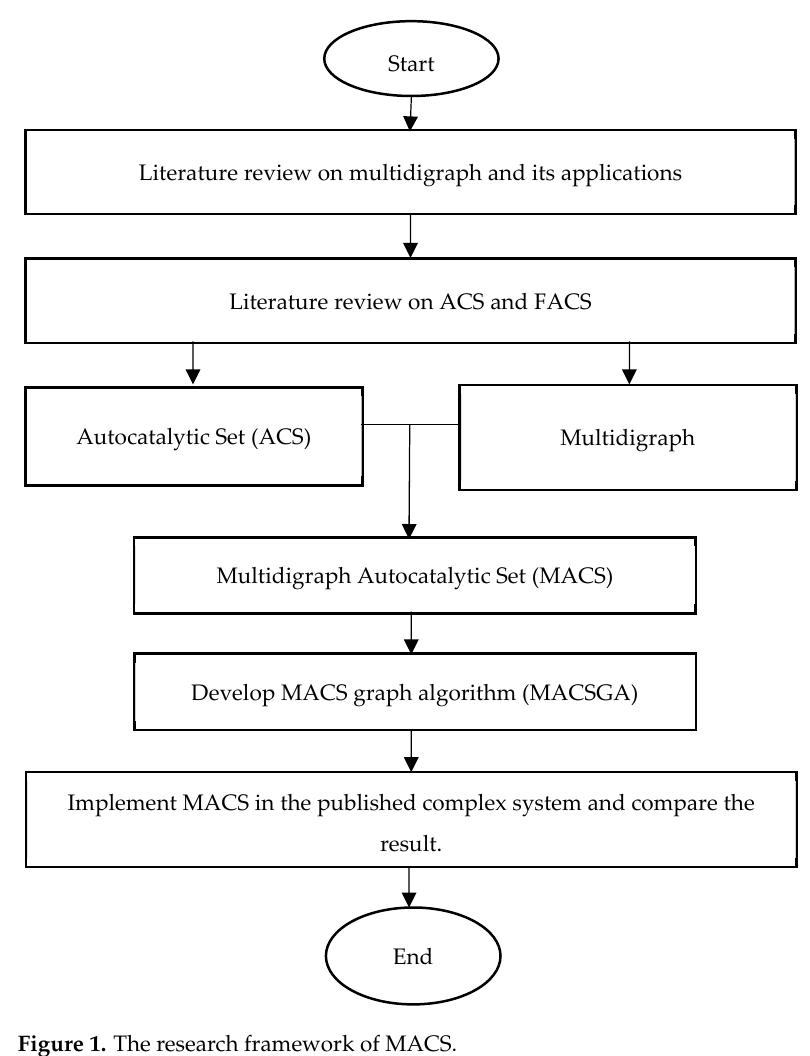
Figure 1. The research framework of MACS .